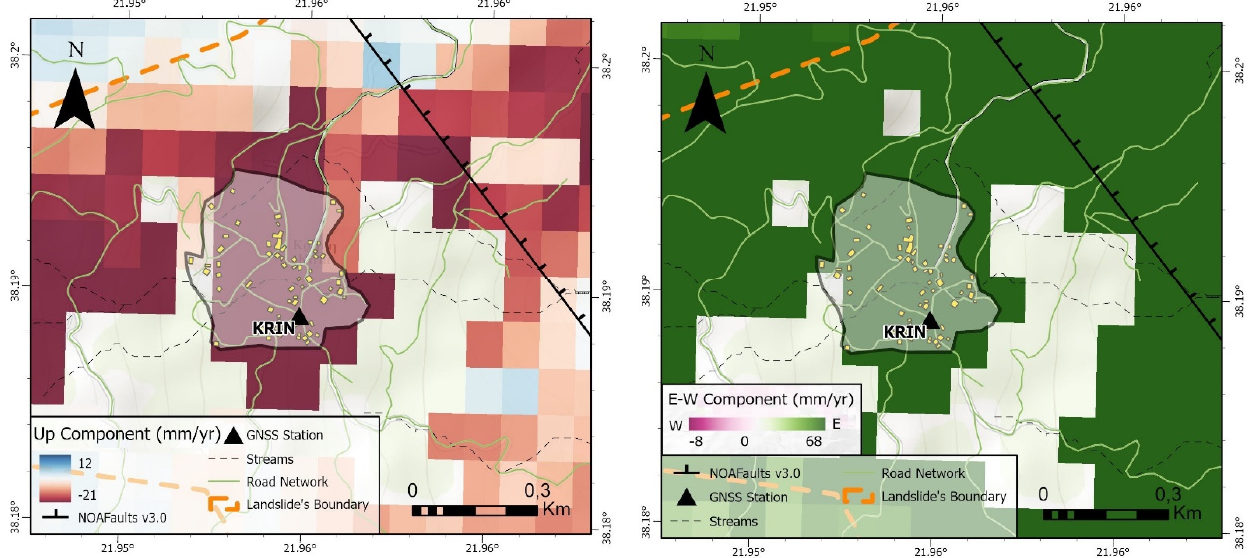
Figure 13. Maps showing InSAR velocities in the area of the village of Krini (shaded polygon: period 2016–2021). Up component ( left ), E-W component ( right ). Yellow boxes indicate houses, and black triangle shows the location of the GNSS station.